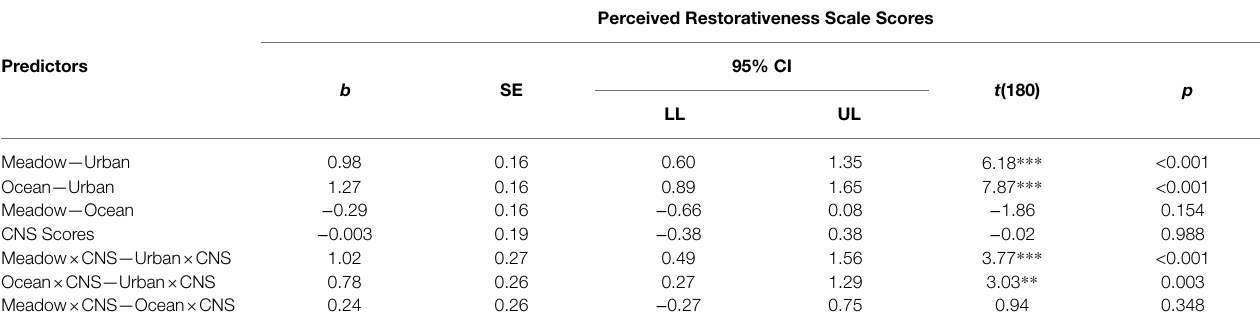
TABLE 7 | The moderation analysis examining the interaction between group and Connectedness to Nature Scale (CNS) scores, in predicting the Perceived Restorativeness Scale (PRS) Score in Study 2.